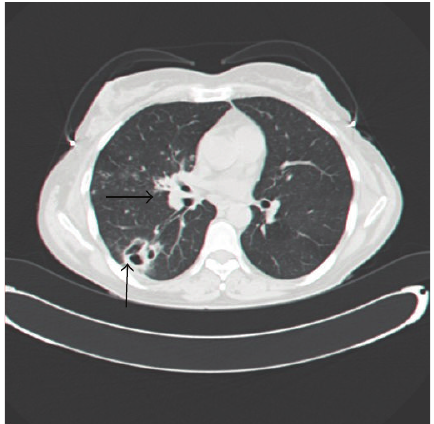
Figure 1: CT scan of the lung, axial view: the horizontal arrow is pointing toward nocardial mass in the right lower lob, while the longitudinal arrow is pointing toward nocardial cavitary lesion in the same